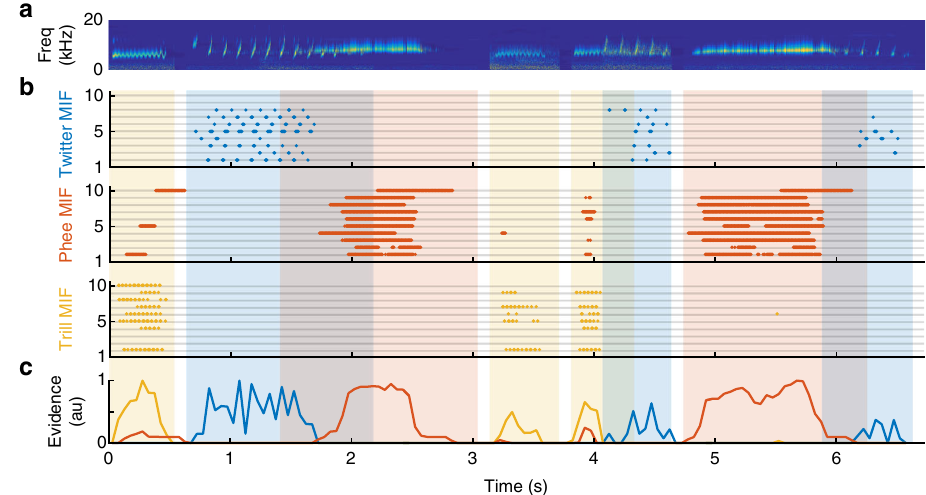
Fig. 5 MIF responses to marmoset call sequences. a The cochleagram of a sequence of marmoset calls, some of which overlap. b Raster plot of the responses of the top 10 MIFs for twitter (top, blue), phee (middle, red), and trill (bottom, yellow). Each dot represents spiking of a putative MIF-selective neuron (i.e. when the response of the MIF exceeds its optimal threshold). c The evidence for presence of a particular call type, de fi ned as the normalized sum of the fi ring rate of all MIF-selective neurons, weighted by their log-likelihood ratio. Over the duration of each call, the call type with the most evidence is considered to be present. Occasional false alarms are usually outweighed by true-positive MIF